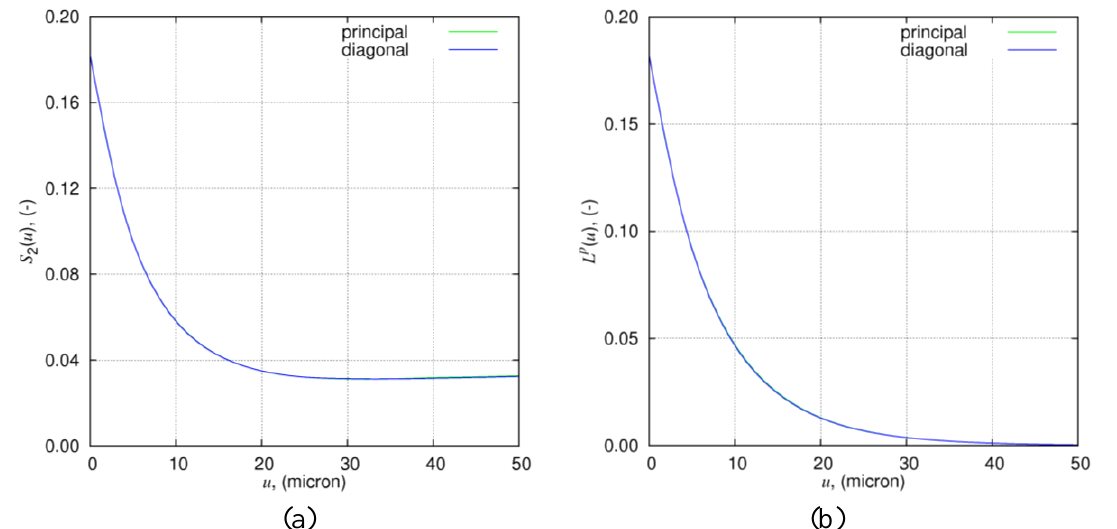
Figure 4. ( a ) Two-point probability function for void phase; ( b ) Lineal-path function for void phase of the porous filter F1. The microstructural descriptors are calculated in both principal and diagonal directions; their course in both directions is almost the